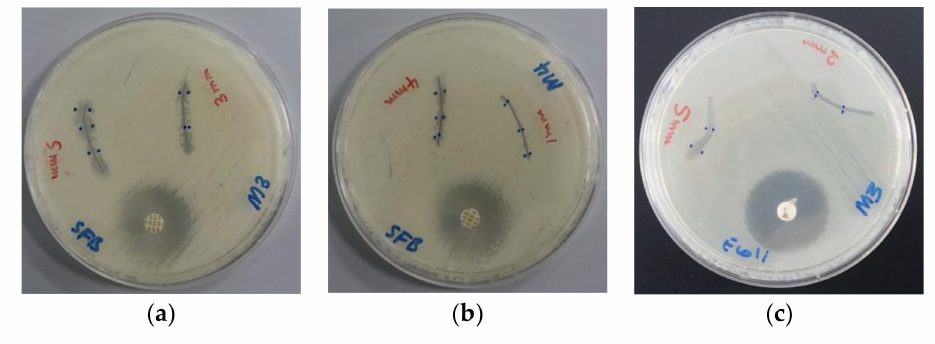
Figure 8. Antimicrobial agar plate methods of dip-coated PGA sutures. From left to right: Bacillus subtilis WDCM 00003 against ( a ) AV-PVP-I 2 ; ( b ) AV-PVP-I 2 -NaI; and E. coli WDCM 00013 against ( c ) AV-PVP-I 2